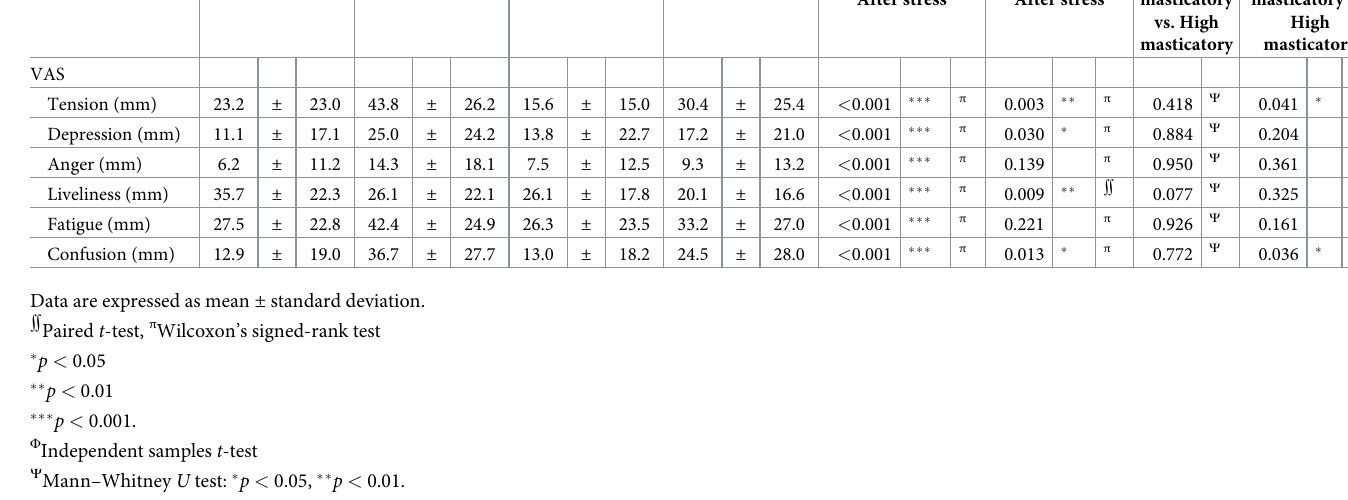
Before After stress stress Before stress vs. After stress After stress